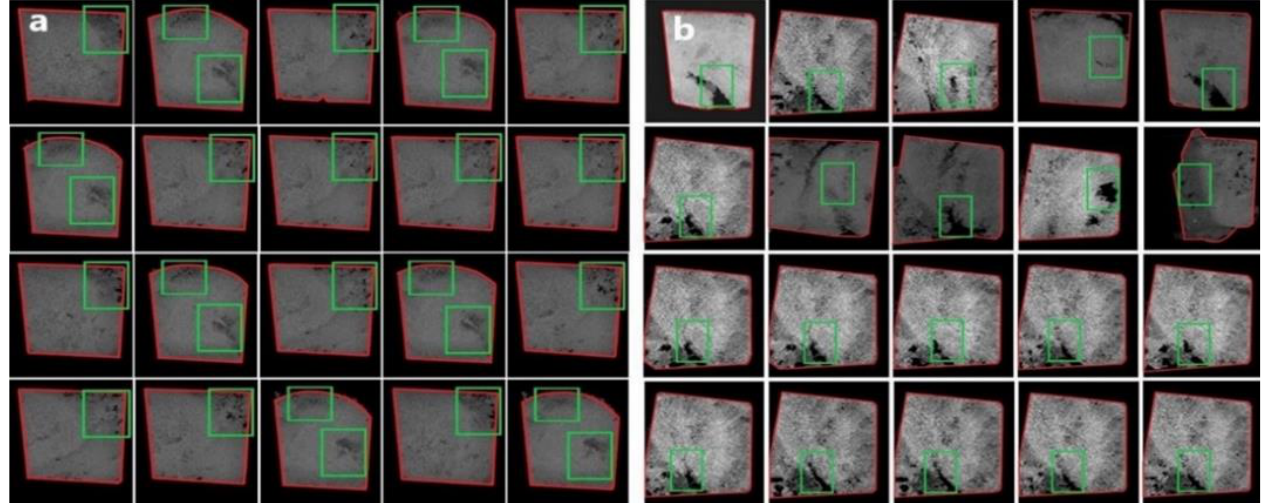
Figure 11. ( a ) New sample training set with the average similarity between the images calculated as 𝒟 KL (ℰ 𝑖 ||ℰ 𝑟 ) ≈ 4.799. Here, the regions containing pores and fractures are marked with green boxes. ( b ) The sample resulting images show the regions identified as pores and fractures by the deep CNN model. The identification accuracy was higher than that presented in Figure 7.